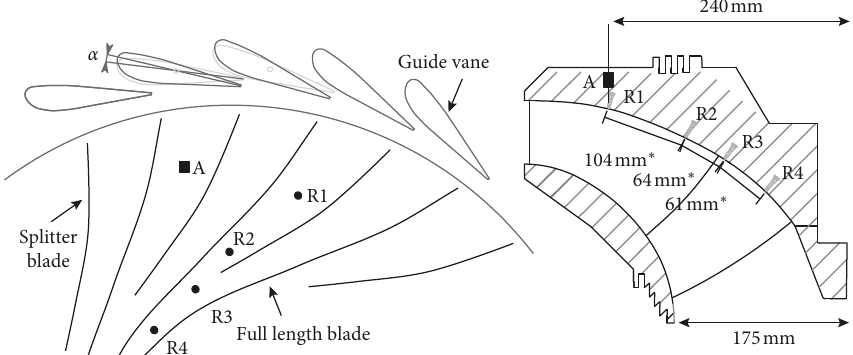
Figure 6: Onboard pressure sensors. The distance between the sensors is indicated. ∗ Distance in R 3 .